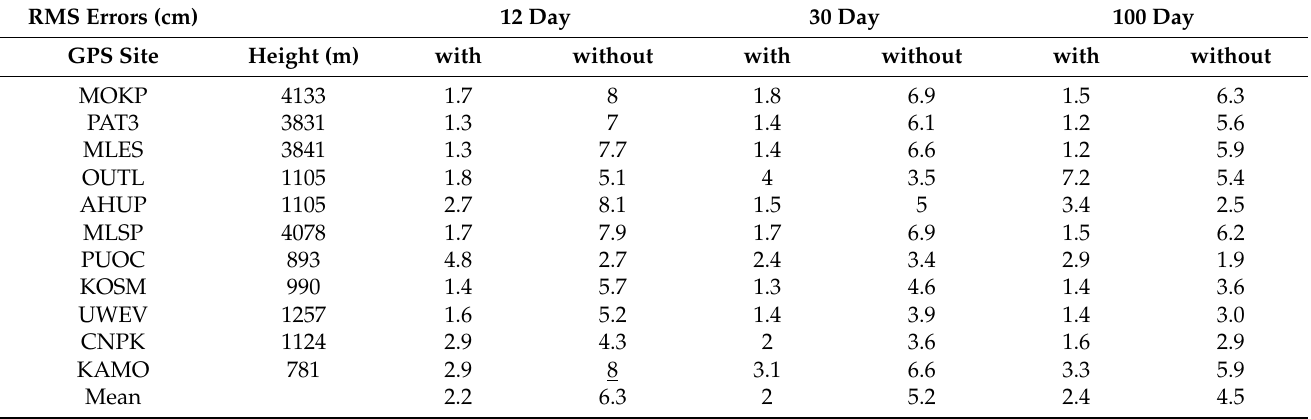
Figure 3. GPS locations on the InSAR cumulative displacement image for part of Hawaii during 2018. Areas covered are the summit of Mauna Loa, the Kilauea area, and the Pu’u O’o region. While other GPS sites are maintained, the areas are the most instrumented.